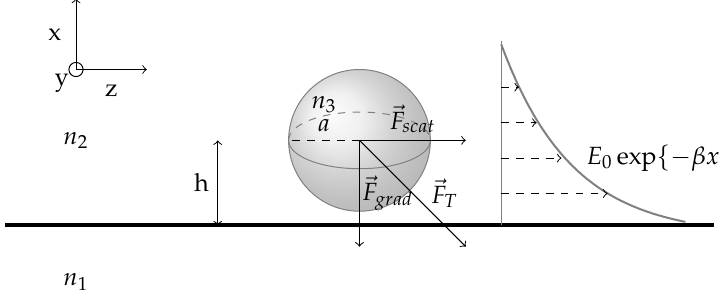
Figure 3. Schematic drawing of a sphere of radius a in the evanescent field of an optical waveguide. The evanescent field having a damping factor β and a maximum amplitude E 0 is expressed as E 0 exp {− β x }